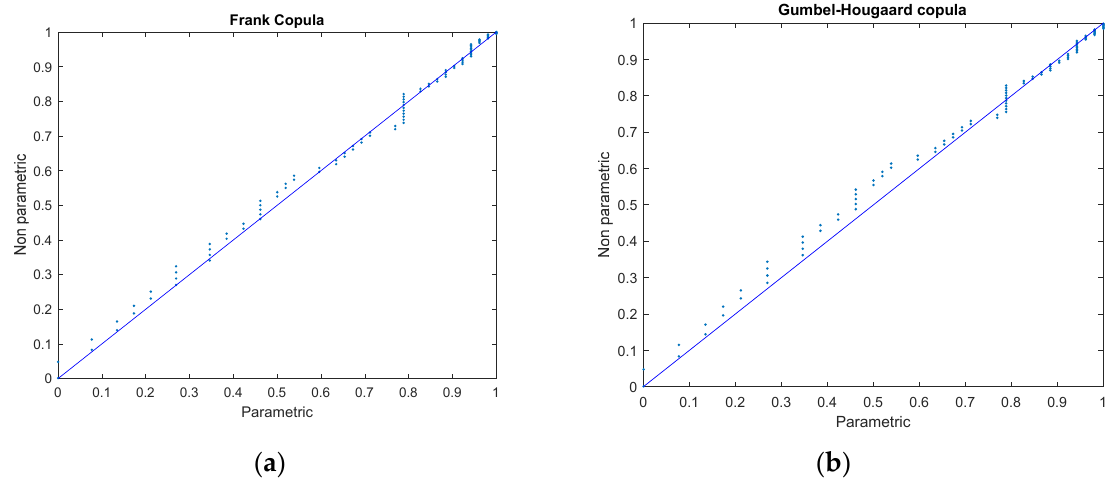
Figure 6. Q-Q plot (nonparametrically estimated K n (z) versus parametrically estimated K(z) ) for: ( a ) Frank copula; ( b ) Gumbel–Hougard copula. A second graphical test was performed by comparing the level curves (isolines) of the theoretical copulas and those of the empirical copula (Figure